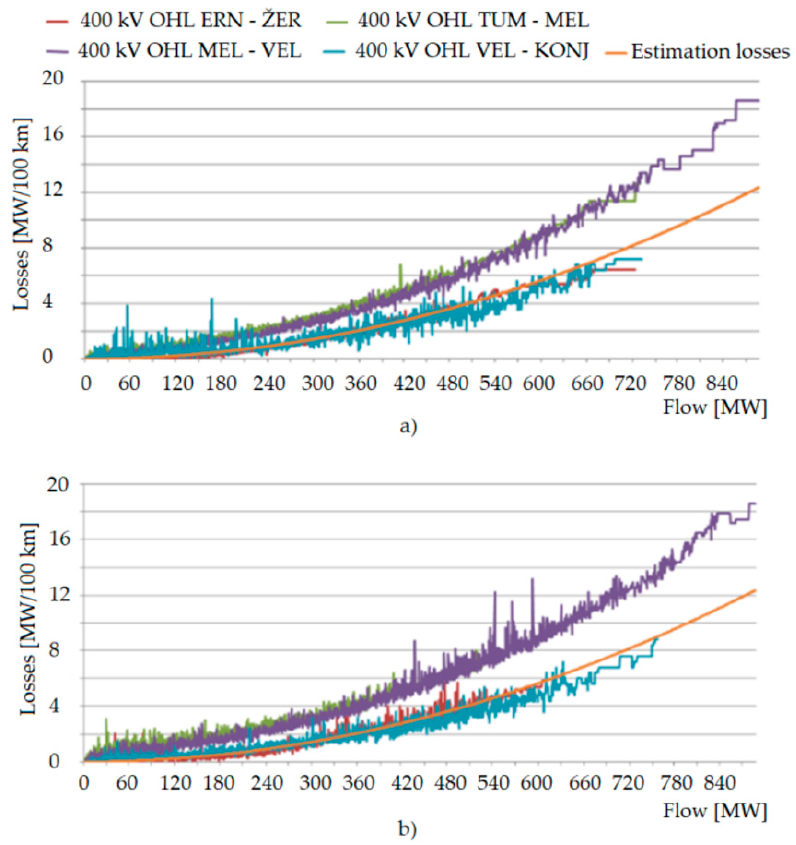
Figure 17. Losses on 400 kV OHLs for periods based on historical measurements with ohm losses expressed with orange line for: ( a ) the winter period; and ( b ) the summer period.